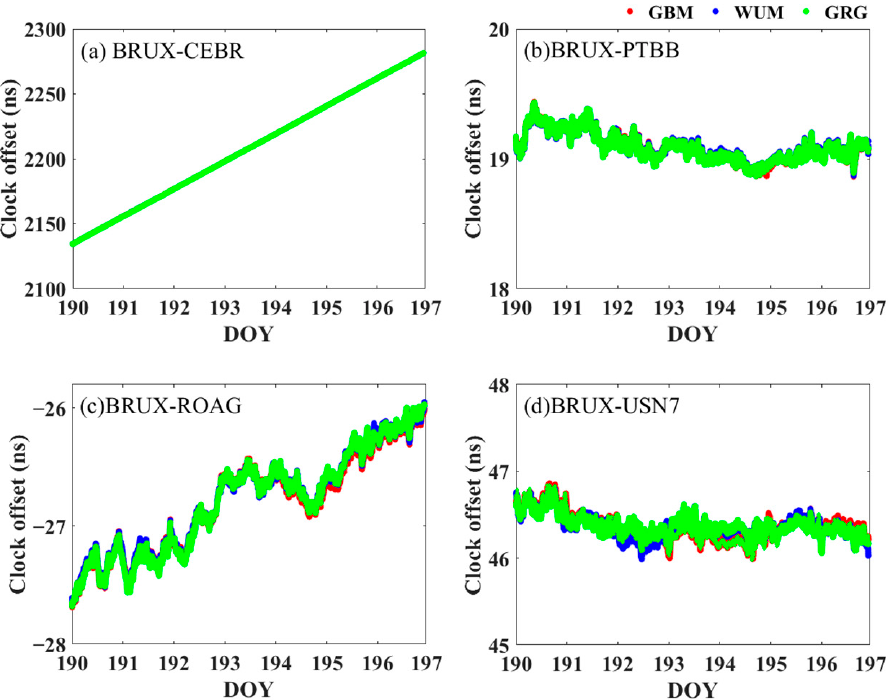
Figure 13. Clock offset sequences of the GBM, WUM and GRG products in the PPP FF1 model. ( a ) BRUX-CEBR time-frequency link; ( b ) BRUX-PTBB time-frequency link; ( c ) BRUX-ROAG time-frequency link; and ( d ) BRUX-USN7 time-frequency link.